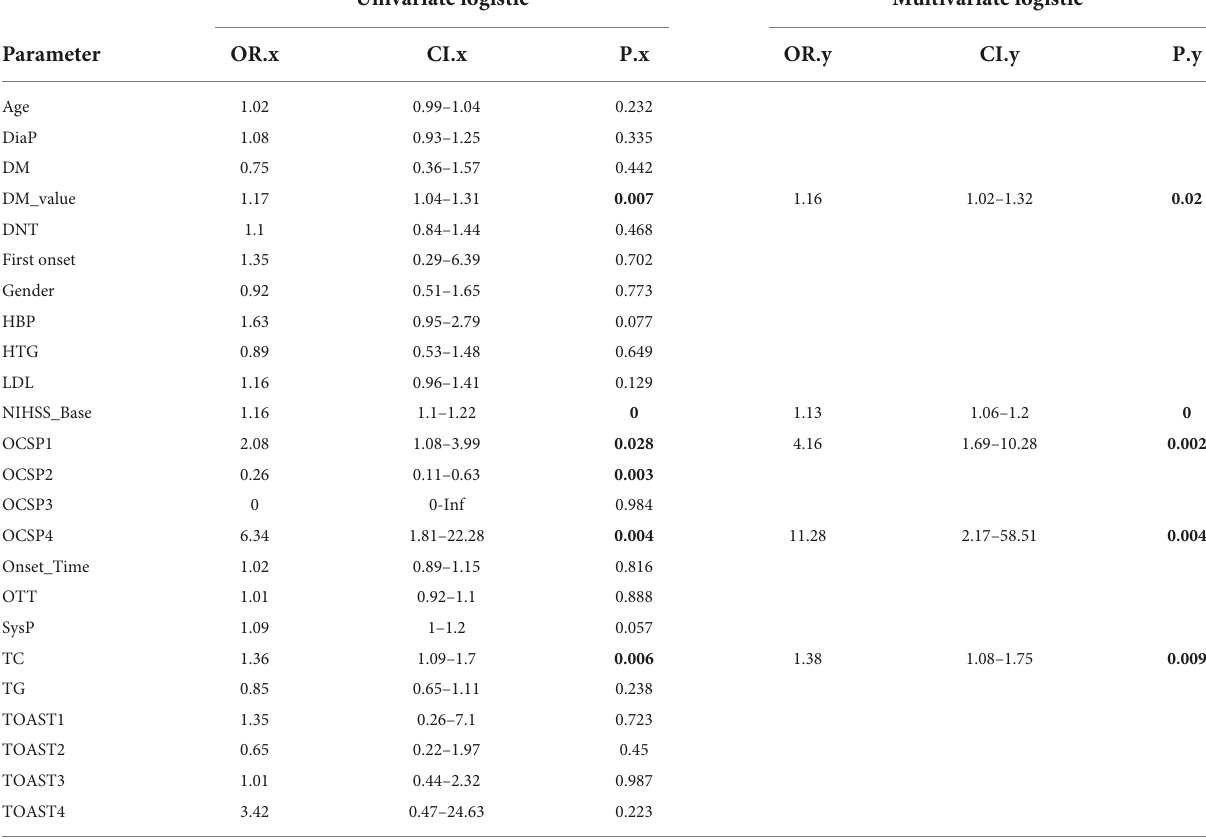
TABLE 2 Logistic regression in the primary cohort for stroke